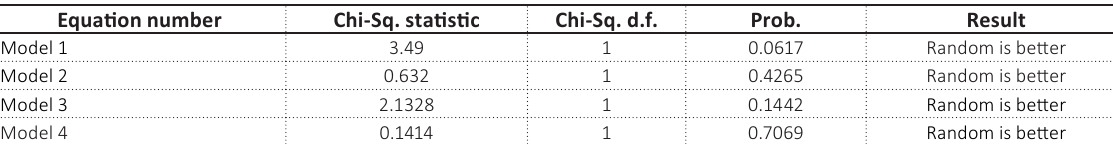
Table 9. Hausman test